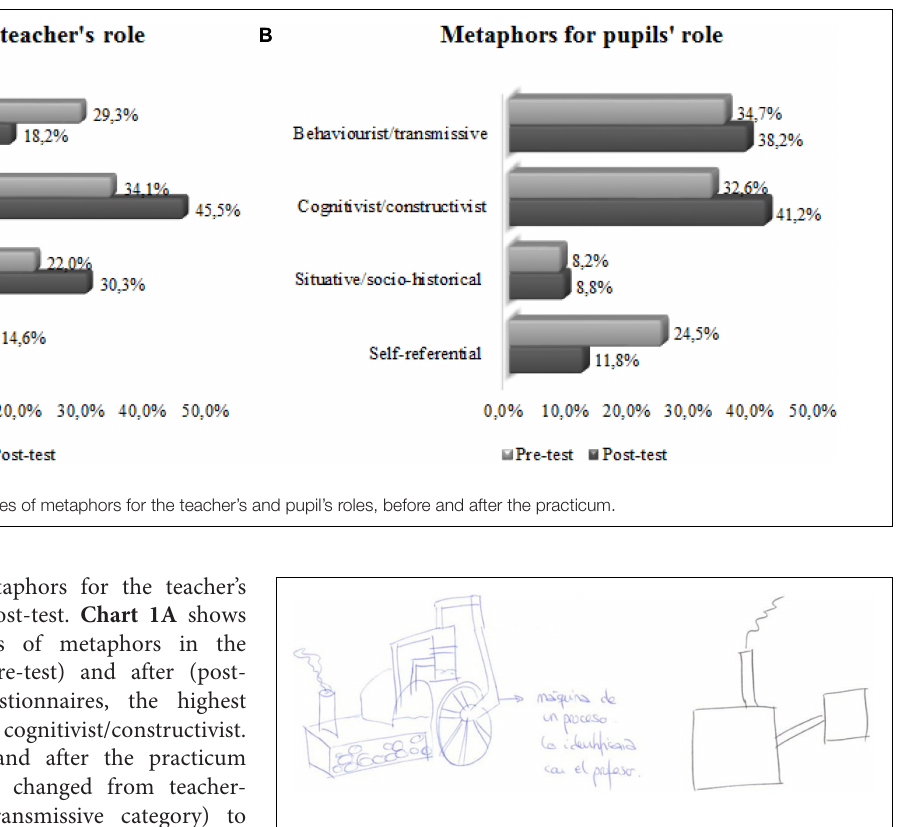
FIGURE 1 | Drawings of E1 for the metaphor of the teacher as machine (pre-and